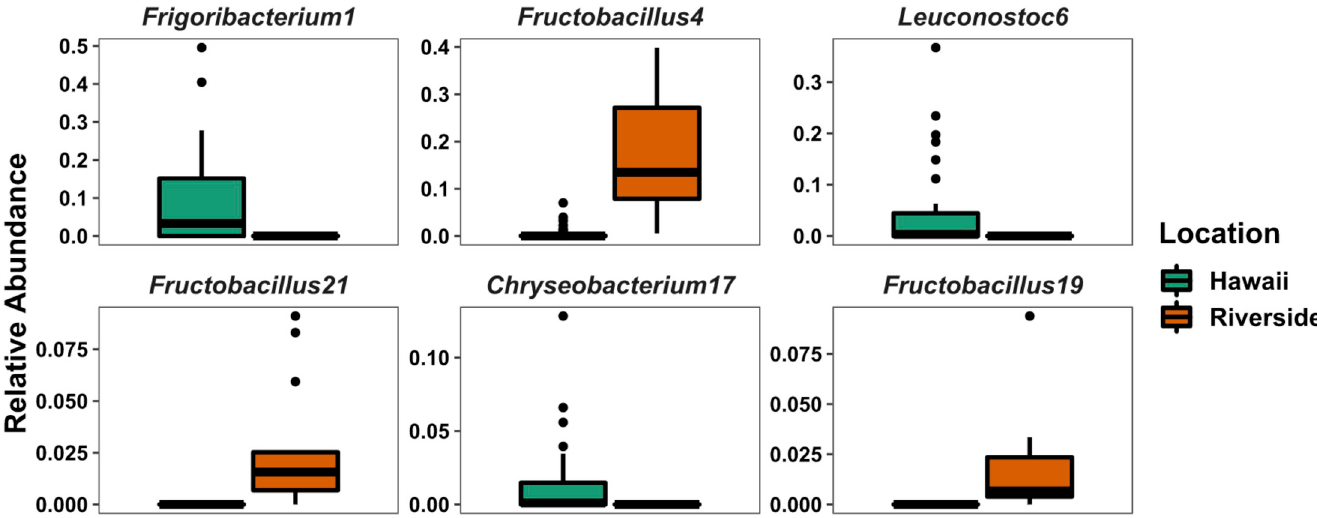
Fig 5. Boxplots showing the relative abundances of bacterial ASVs at greater than 0.5% overall relative abundance that were differentially abundant between Riverside and Hawaiian locations as tested with ANCOM.